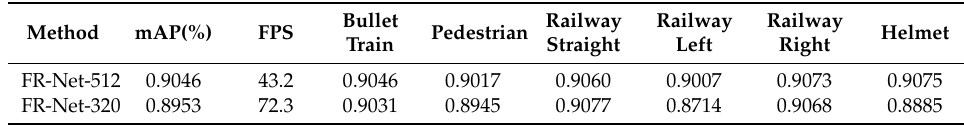
Table 6. Performance with respect to different input